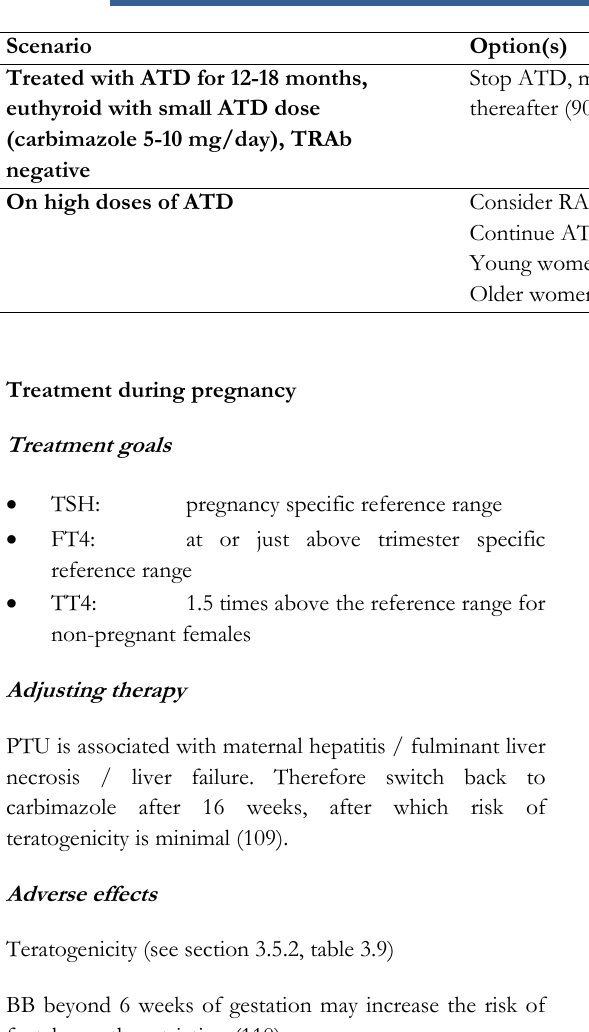
Table 4.8. Pre-conception treatment